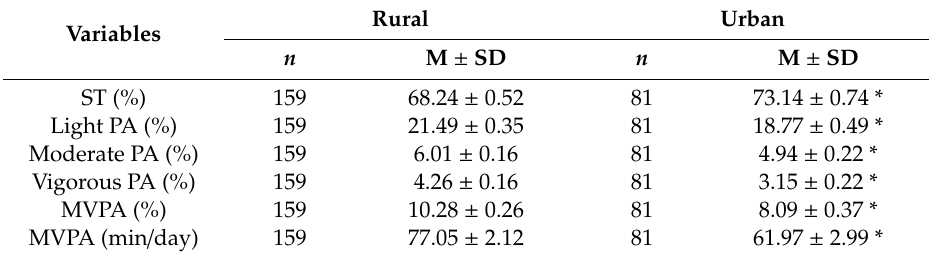
Table 3. Descriptive statistics and results of physical activity (PA) and sedentary time (ST) ANCOVAs in rural and urban adolescents.